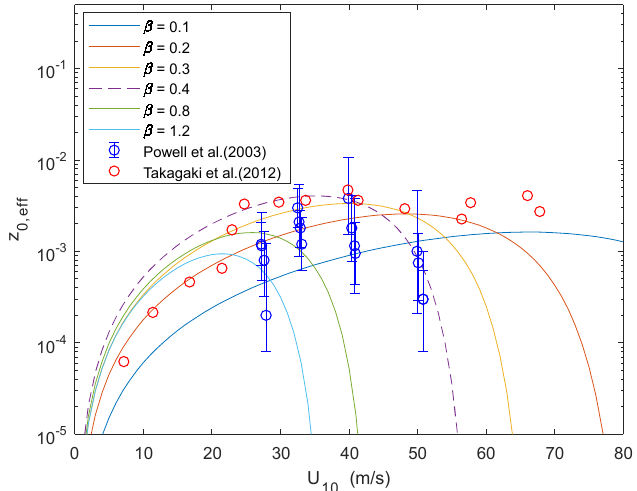
Figure 9. Variations of effective sea surface roughness with wind speed, considering the impact of sea spray droplets.